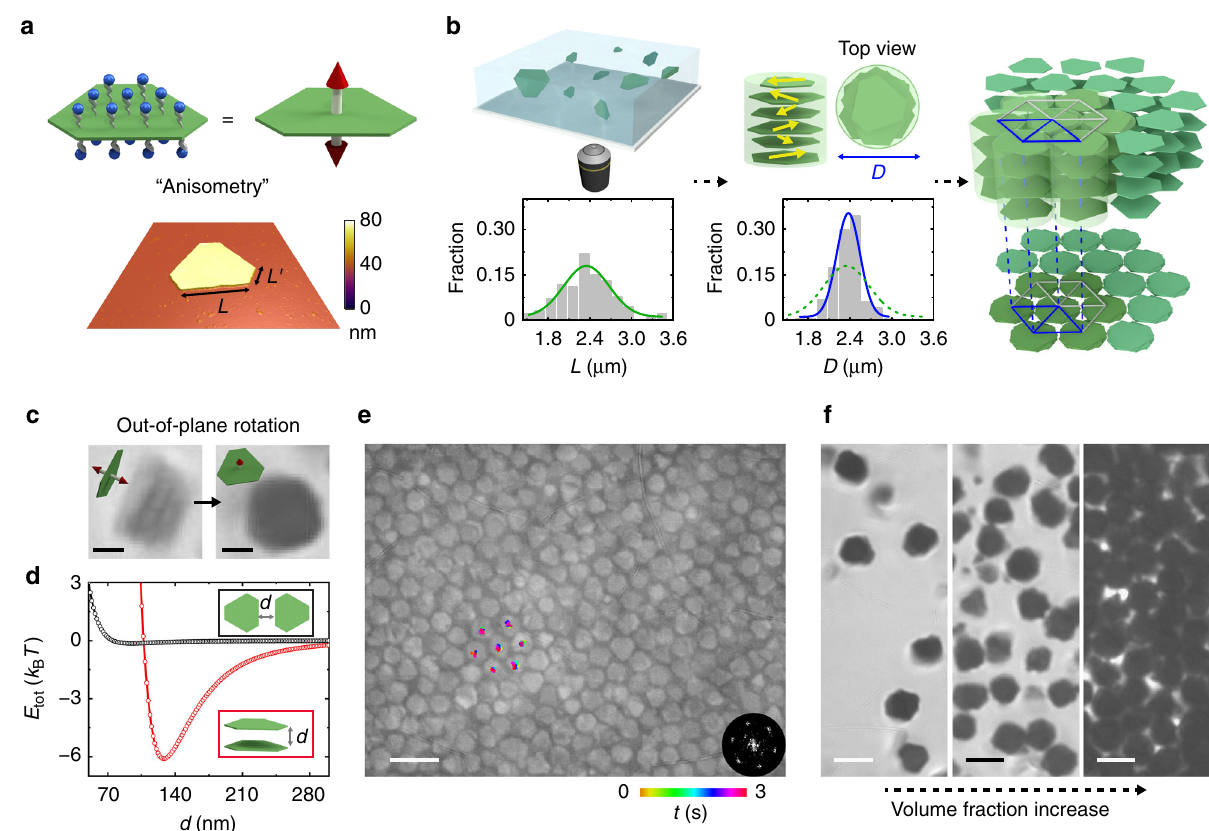
Fig. 1 Hierarchical self-assembly of polydisperse, anisometric plates into a 3D lattice. a Top: schematics of anisometric silver plates (green) coated with thiolated COO ‒ ligands (blue) and their directional attractions (red arrows). Bottom: a representative atomic force microscopy (AFM) scan over an anisometric plate. The color bar represents height. Scan area: 5 µ m × 5 µ m. b Schematics describing the hierarchical building process: plates fi rst stack into columns (yellow arrows denoting the random orientations of the plates), which then assemble into a hexagonal lattice. The graphs below show the distribution of the long side length L of plates (left, green curve) and that of column projection diameter D (right, blue curve). The L distribution was rescaled so that (cid:1) L and (cid:1) D have the same value (2.36 µ m) for direct comparison. c Time-lapse optical microscopy images and schematics showing the lying and standing orientations of the same rotating column. d Theoretical calculations of the net pairwise interactions E tot of two plates in the face-to-face (red circles) and side-by-side (black circles) con fi gurations as a function of the plate ‒ plate distance d (labeled in inset schematic). e An optical microscopy image showing a hexagonal lattice, overlaid with tracked trajectories of the central positions of the column projections. The image was processed as detailed in Supplementary Fig. 5 and Supplementary Note 4. The bottom right inset is a fast Fourier transform (FFT) pattern of the image. f Optical microscopy images showing column arrangements as their concentration increases (from left to right). Ionic strength in c – f : 0.5 mM. The schematics were not drawn to scale. Scale bars: 1 µ m in c ; 5 µ m in e ; 3 µ m in